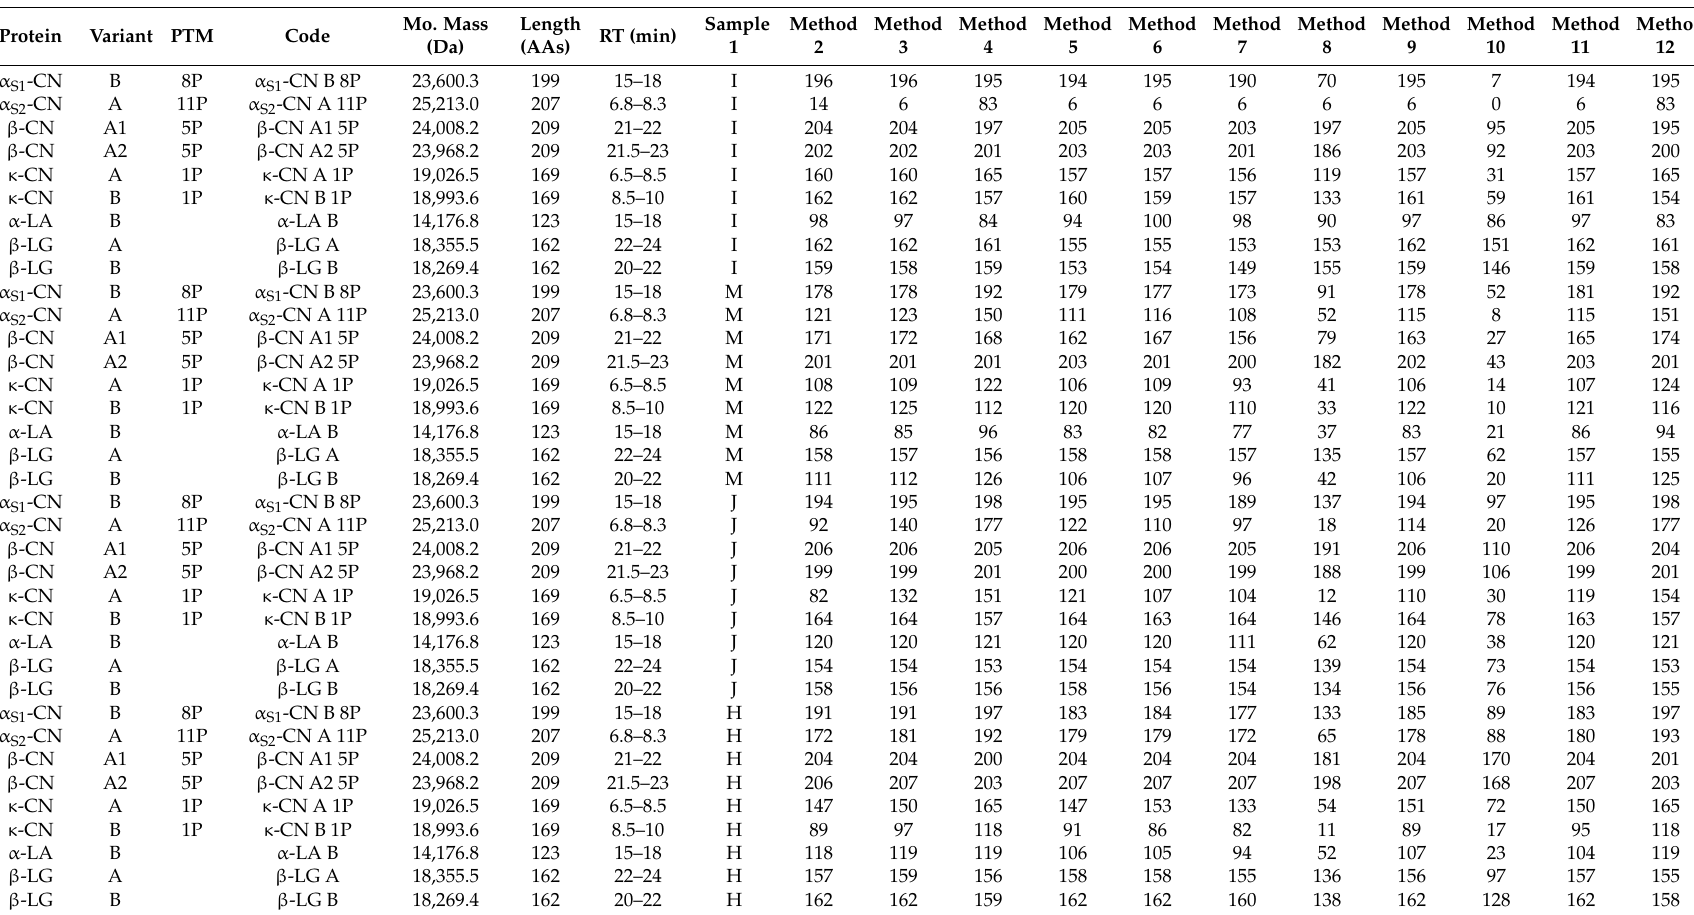
Table 3. Number of AAs top-down sequenced across the 11 MS2 methods from the nine most abundant milk proteins with the individual standards, mixed standards, and milk